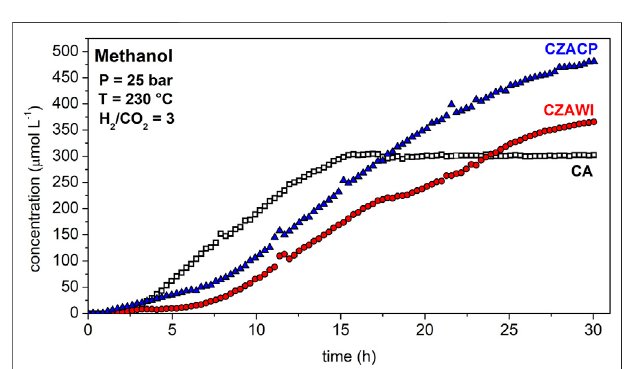
FIGURE7| MethanolconcentrationattheoutletofthereactorusingCA, CZAWI, and